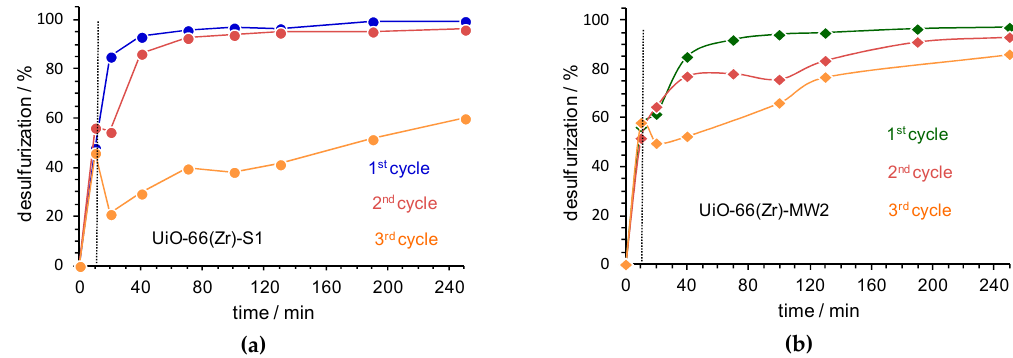
Figure 5. The desulfurization profile obtained the three ECODS cycles, catalyzed by UiO-66(Zr)-S1 ( a ) and UiO-66(Zr)-MW2 ( b ), using the biphasic system model diesel/MeCN (1:1) and H 2 O 2 /S=13, at 50 °C. The vertical dashed lines indicate the beginning of the catalytic step in the ECODS process by adding oxidant (H 2 O 2 ).